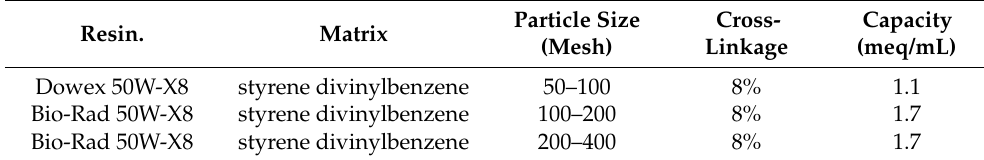
Table 1. Properties of the studied cationic exchange resins.